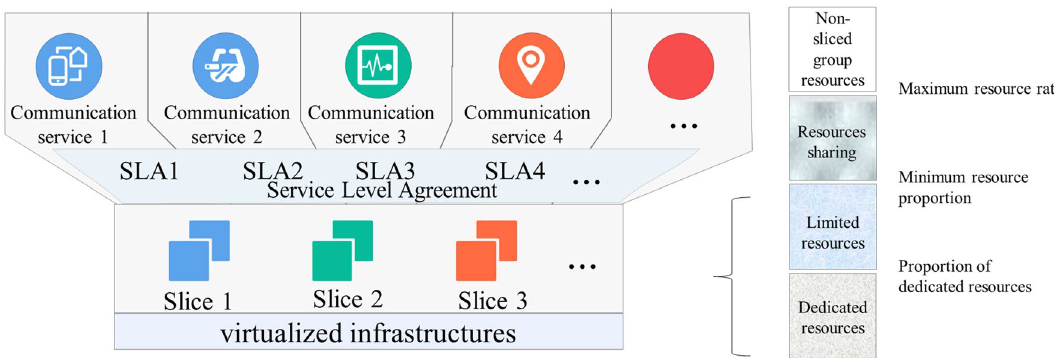
Figure 4. A schematic diagram of the 5 g slice group resource